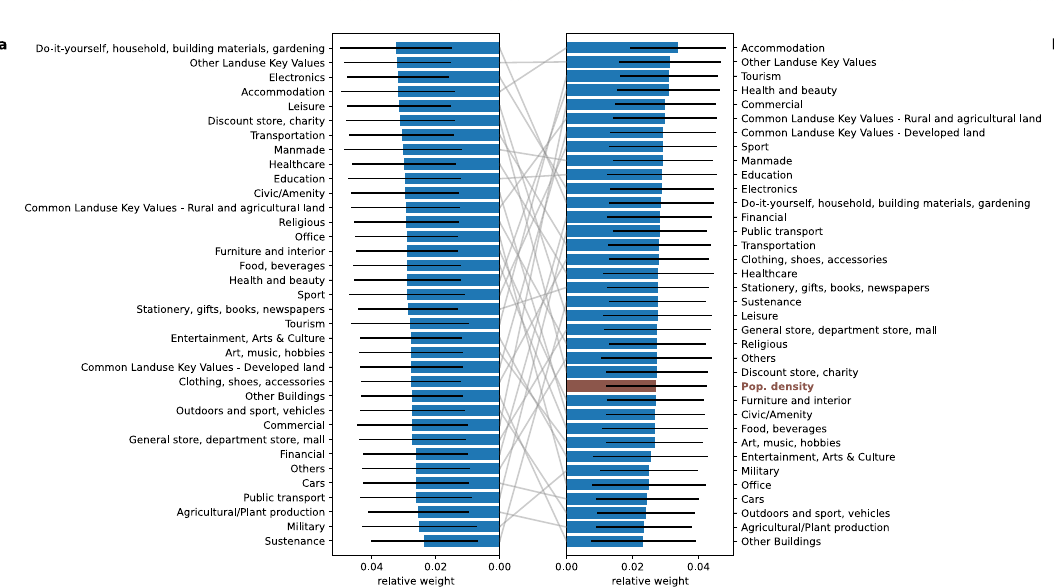
Figure 4. Amenity distributions. The distributions do not collapse to a single distribution which suggests that a single measure e.g., POI count, cannot reproduce the distribution of all the amenities.